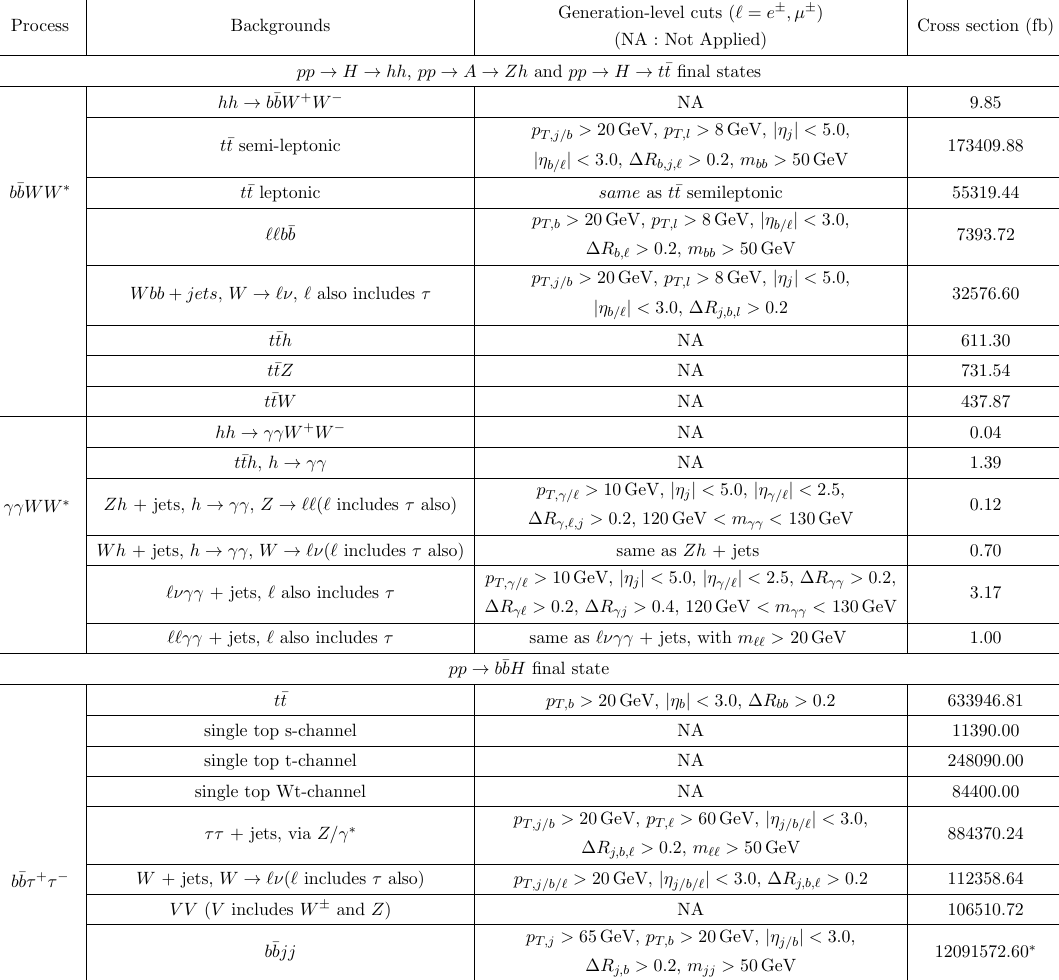
Table 20 . Generation level cuts and cross-sections for the signals and various backgrounds used in the analyses. The backgrounds labelled with analysis. The fake rates used are 0 : 35% [211] for j